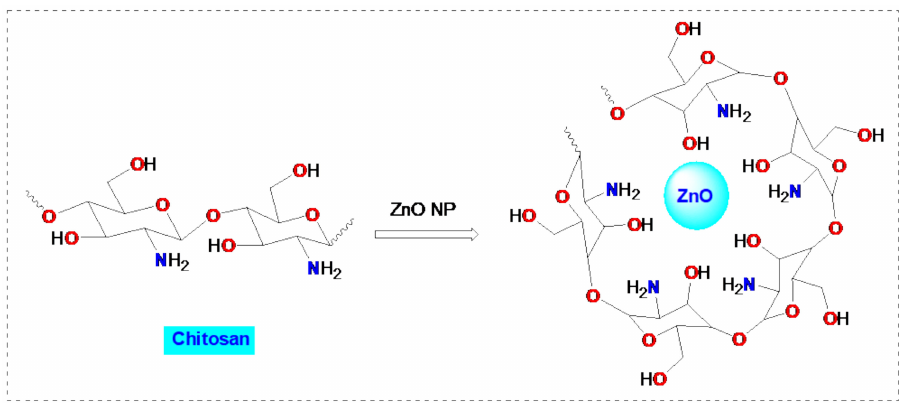
Figure 1. Chitosan − ZnO nanocomposite presented in simplified